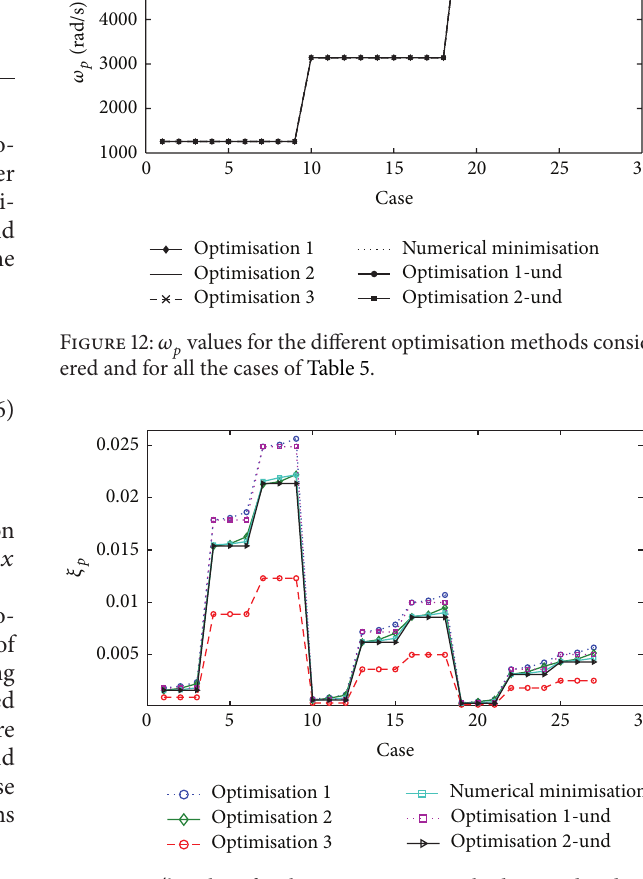
Figure 13: 𝜉 𝑝 values for the optimisation methods considered and for all the cases shown in Table